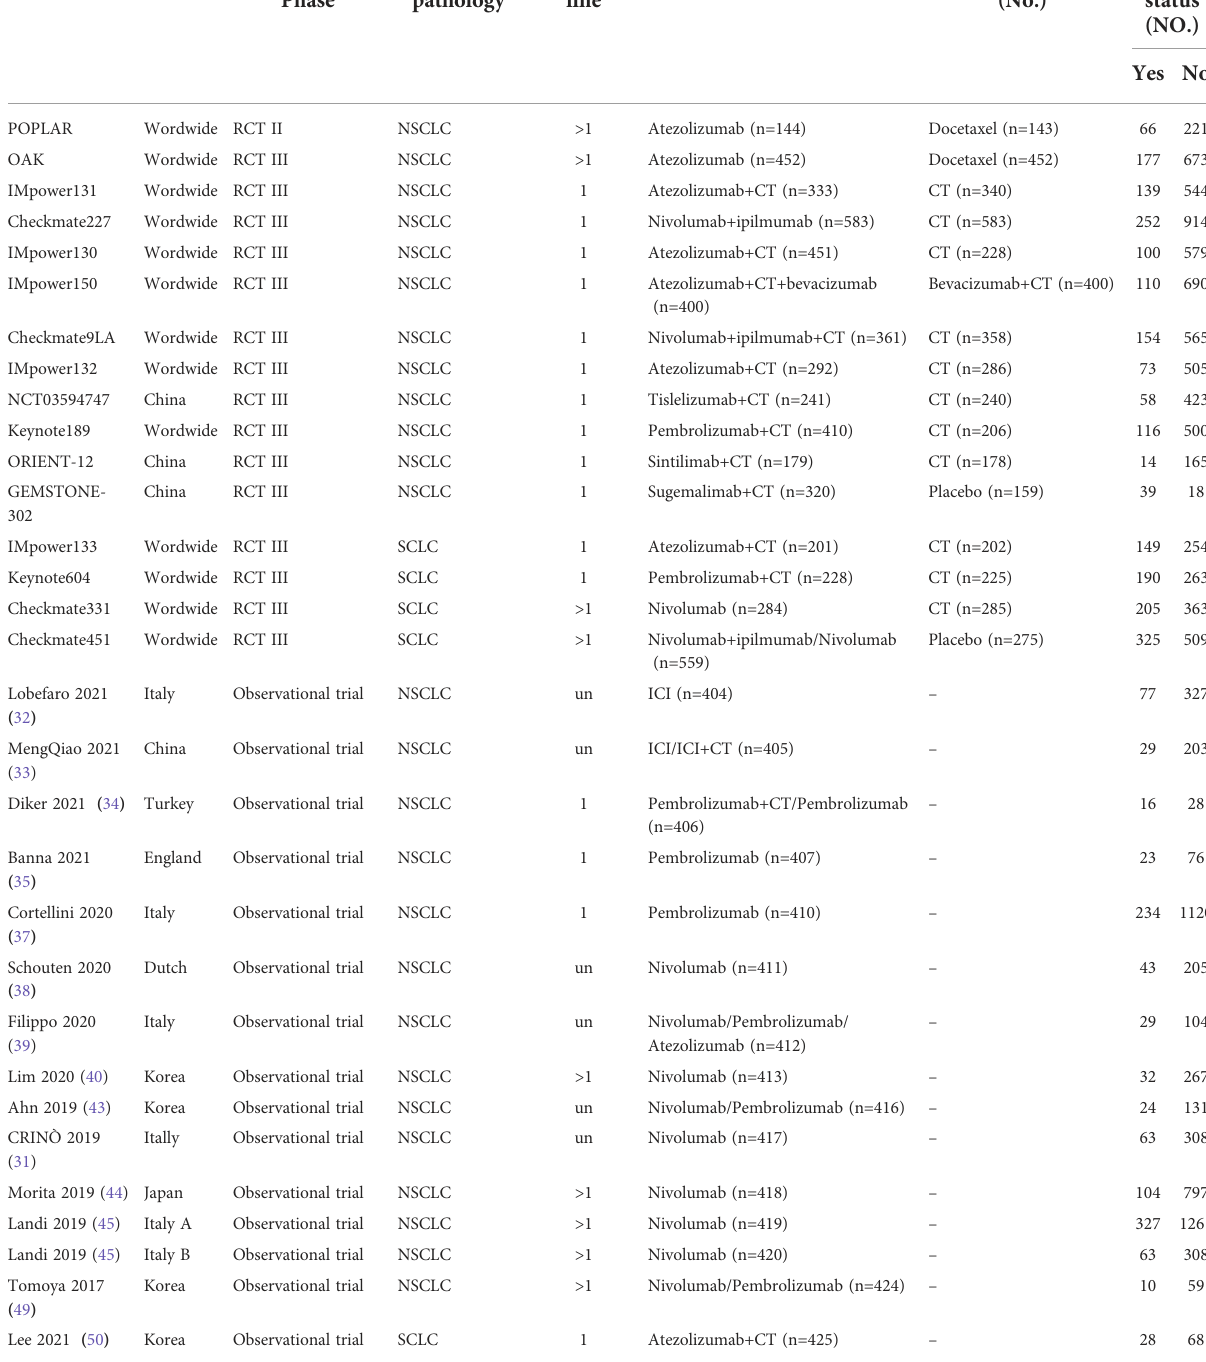
TABLE 1 Summary of studies included in the present